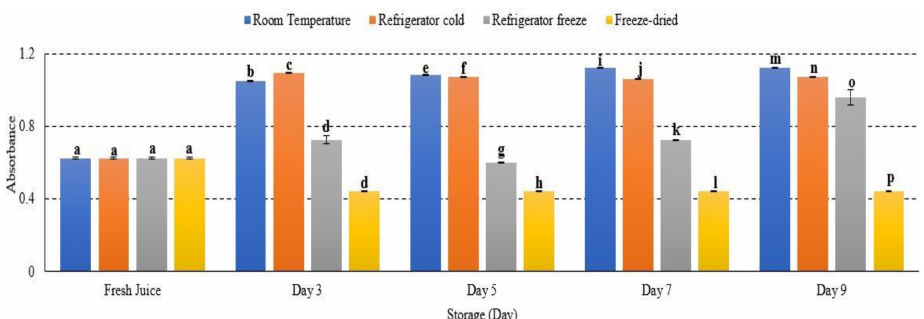
Figure 6. Browning reaction of watermelon juice during storage at different temperature. Different letters indicate significant differences between samples p < 0.01.